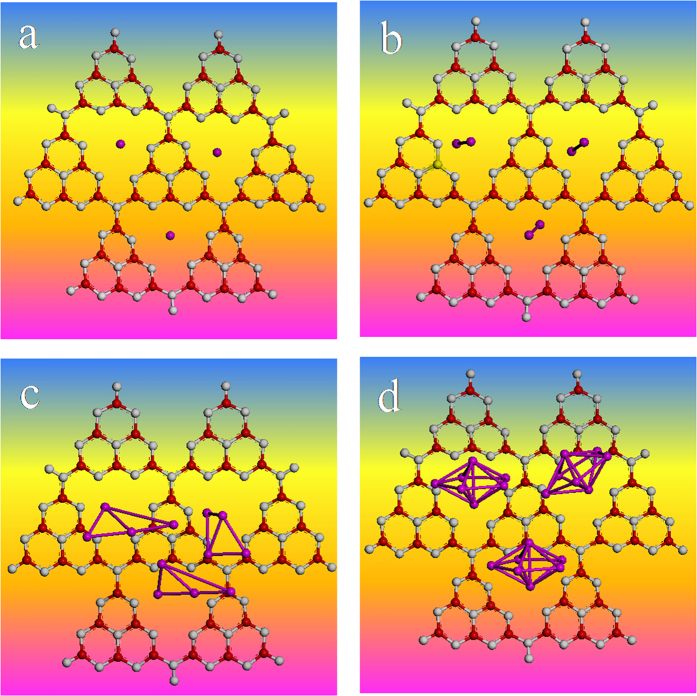
The optimized geometries of S-g-C3N4/(3-Agn): (a) n = 1, (b) n = 2, (c) n = 4 and (d) n = 7, respectively.